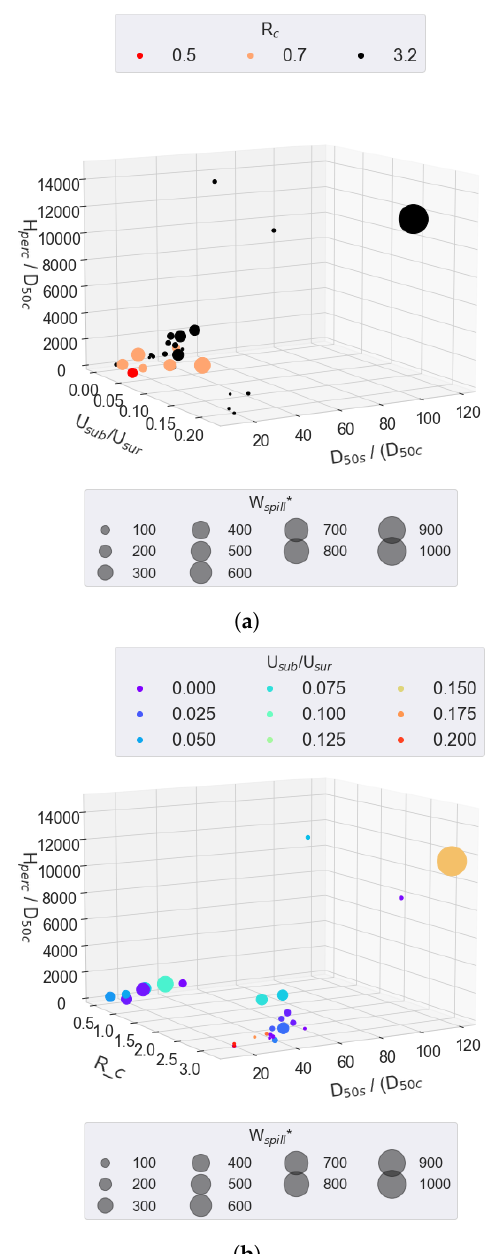
Figure 8. Maximum dimensionless infiltration of fine particles into the substrate as a function of: ( a ) U sub / U sur , D 50 s / D 50 c and W spill ∗ ; ( b ) R c , D 50 s / D 50 c and W spill ∗